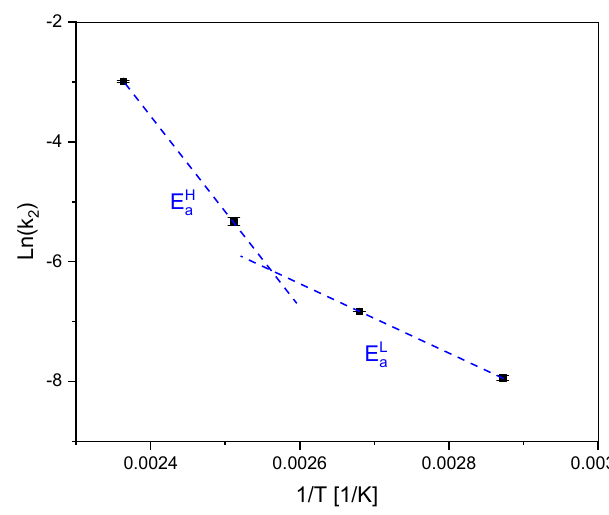
Figure 3. Correlation of the second-order kinetic rate constants k 2 to the Arrhenius relationship. (linear regression fit for 150 °C + 125 °C and 100 °C + 75 °C, respectively: blue dashed lines).